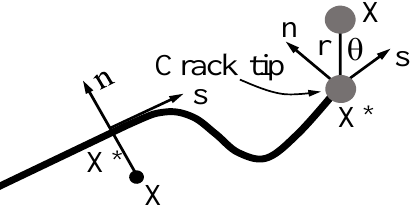
Figure 3. Illustration of normal and tangential coordinates for a smooth crack [24].